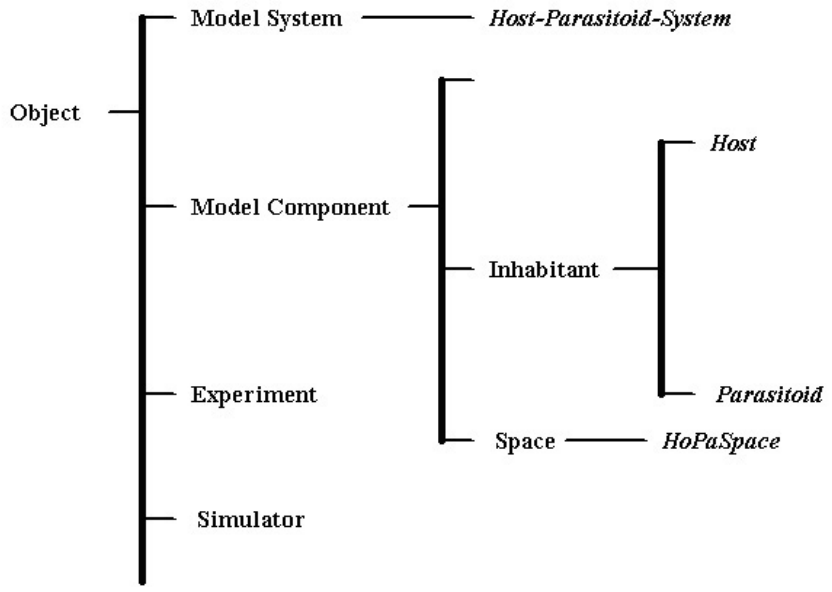
FIGURE 4. Class hierarchy for an object-oriented simulation of a cotton plant and associated insect pests. Reproduced from Baveco and Lingeman[3] with permission. HoPaSpace covers the spatial distribution of